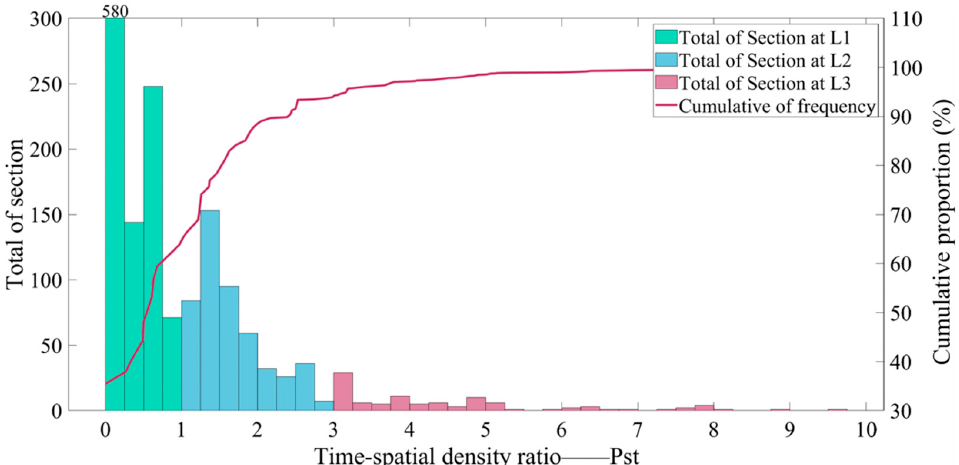
Figure 2. Statistics on the number and cumulative frequency of sections at differentiated risk levels; each 1 km section is counted 4 times according to the weather conditions (sunny, cloudy, overcast, and rainy).